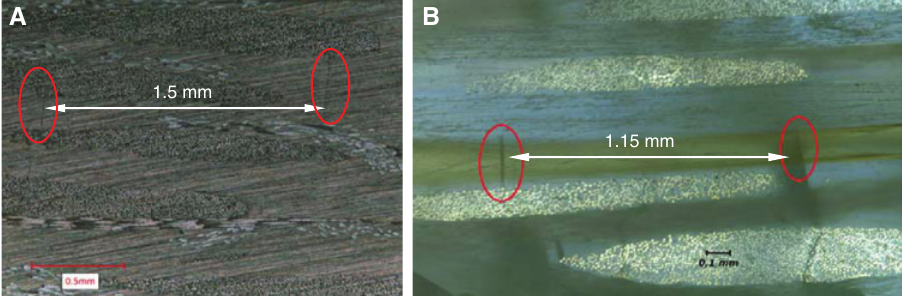
Figure 7: Microscopic images of the cross-section of fatigue tested specimens where the cross-section is parallel to the loading direction or the length of fiber optic cable. A number of transverse cracks, and two transverse cracks just above the fiber optic cable can clearly be seen in (A) and (B)